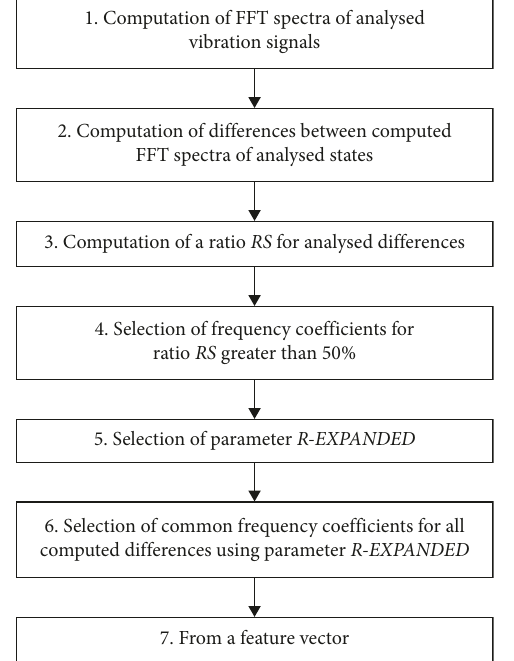
Figure 9: Flow diagram of the MSAF-RATIO-50-SFC-